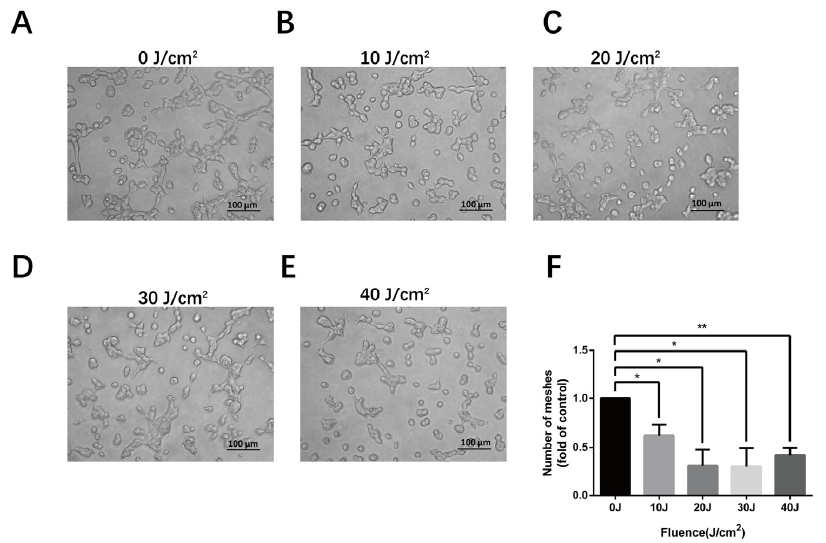
Figure 3. The suppression of tube formation in HMEC-1 after 590 nm LED irradiation. ( A – E ) The cell tube formation condition 8 h after 0–40 J/cm 2 LED irradiation. ( F ) The comparison of mesh numbers. Data are normalized to the control and are shown as mean values with SD from three independent tests. *, p < 0.05; **, p < 0.01. Bar, 100 µ m.